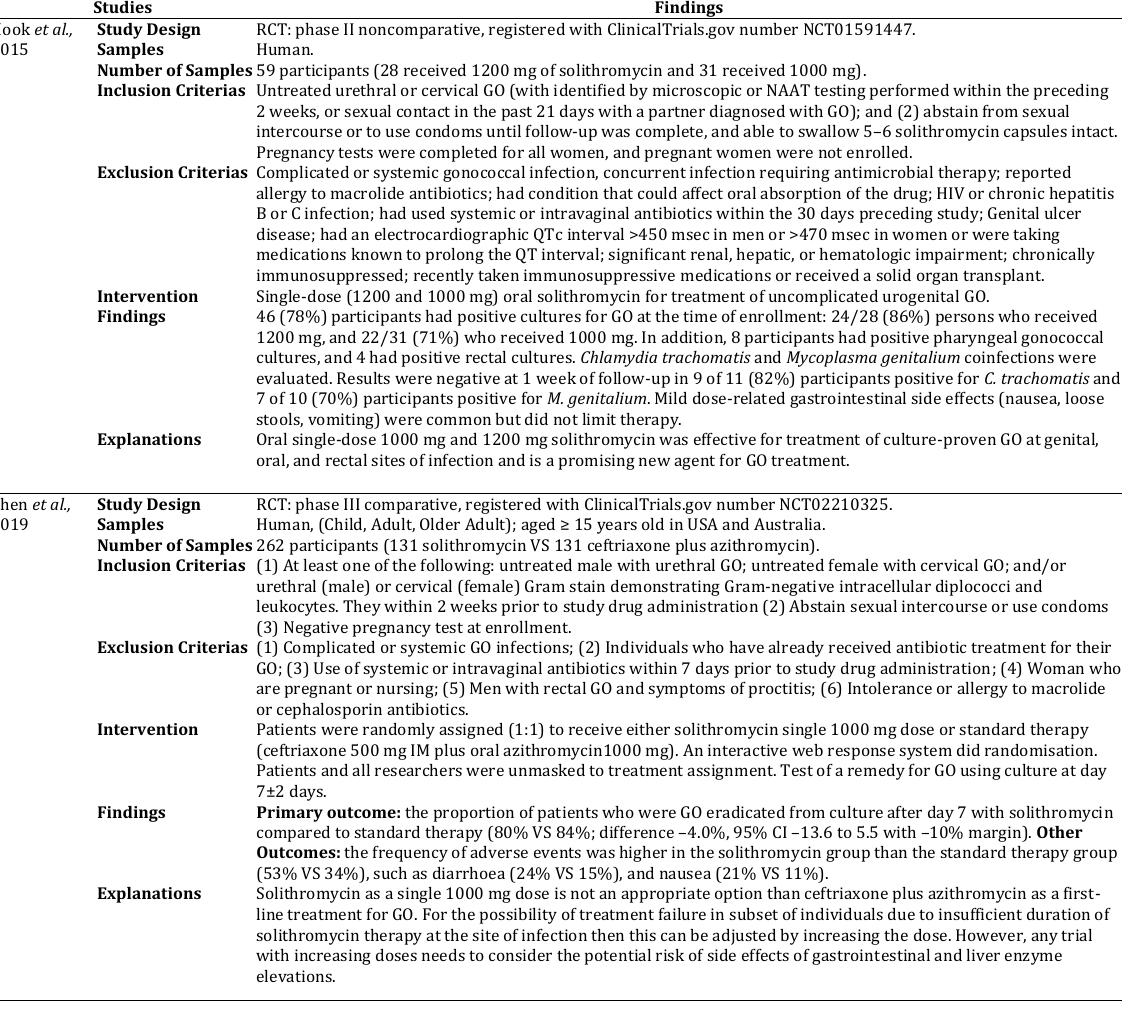
Table IIb. A Summary of multiple types of research about the antibacterial effect of solithromycin in combating N. gonorrhoeae . Studies Findings Hook et